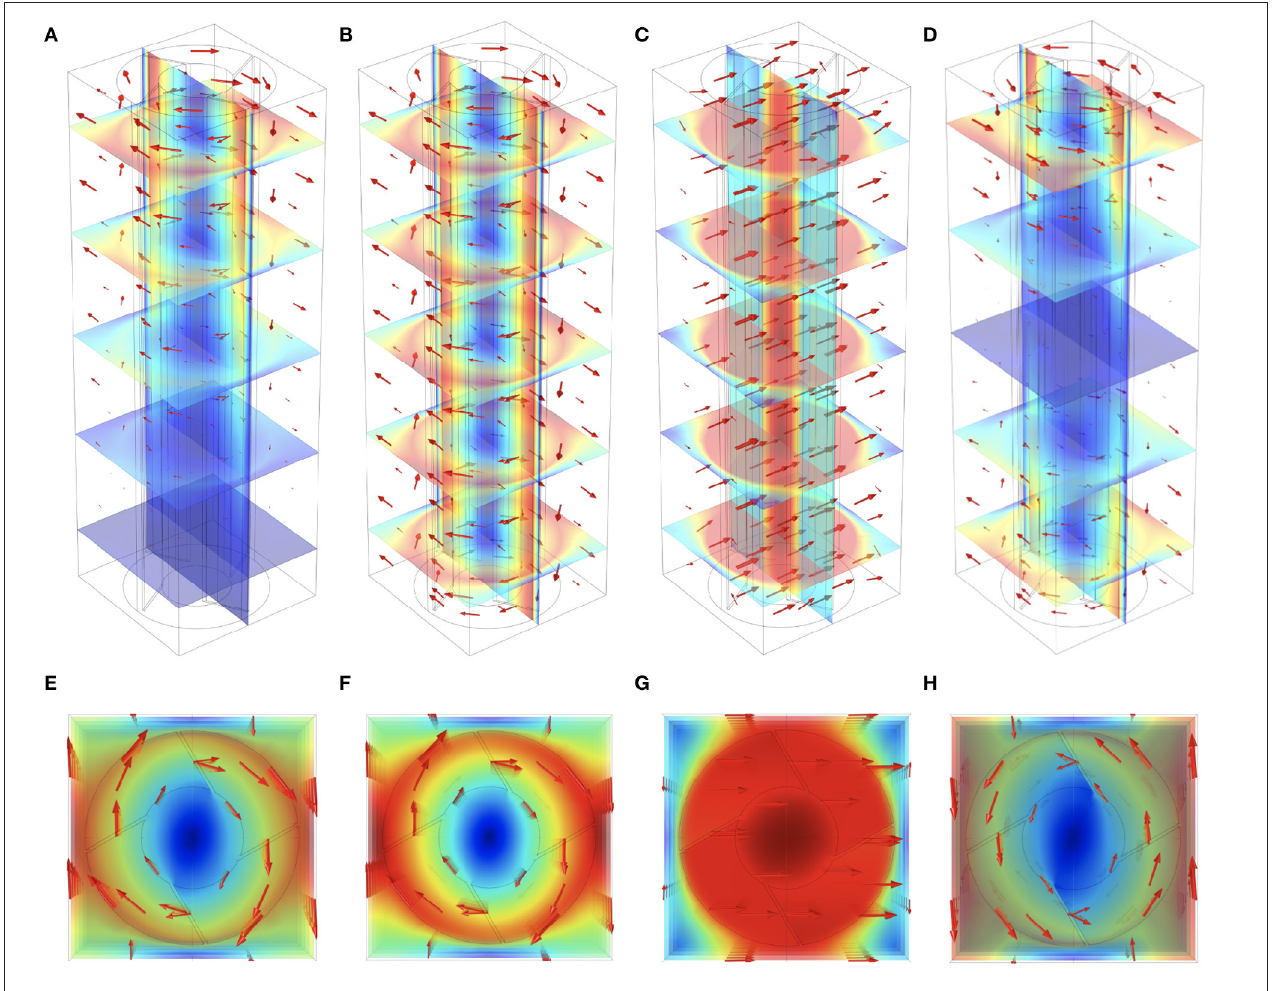
FIGURE 2 | Representative eigenmodes for cylindrical inertial resonators (IRs) with four inclined ligaments at high-symmetry point X of the irreducible Brillouin zone Ŵ XM : (A,E) Rotational mode at 48.5 Hz (IR clamped at bottom, third mode in Figure 1D ); (B,F) Rotational mode 38.6 Hz (fourth mode in Figure 1B ); (C,G) Longitudinal mode at 45.8 Hz (sixth mode in Figure 1B ); (D,H) Torsional mode at 63.8 Hz (seventh mode in Figure 1B